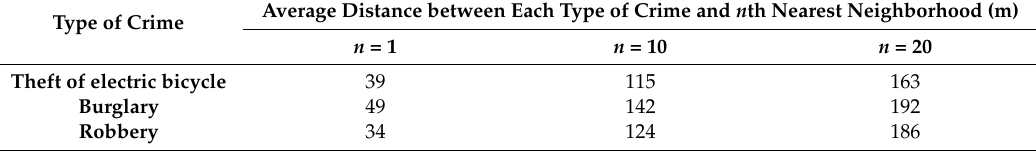
Table 2. Average distance between crimes and land use features.